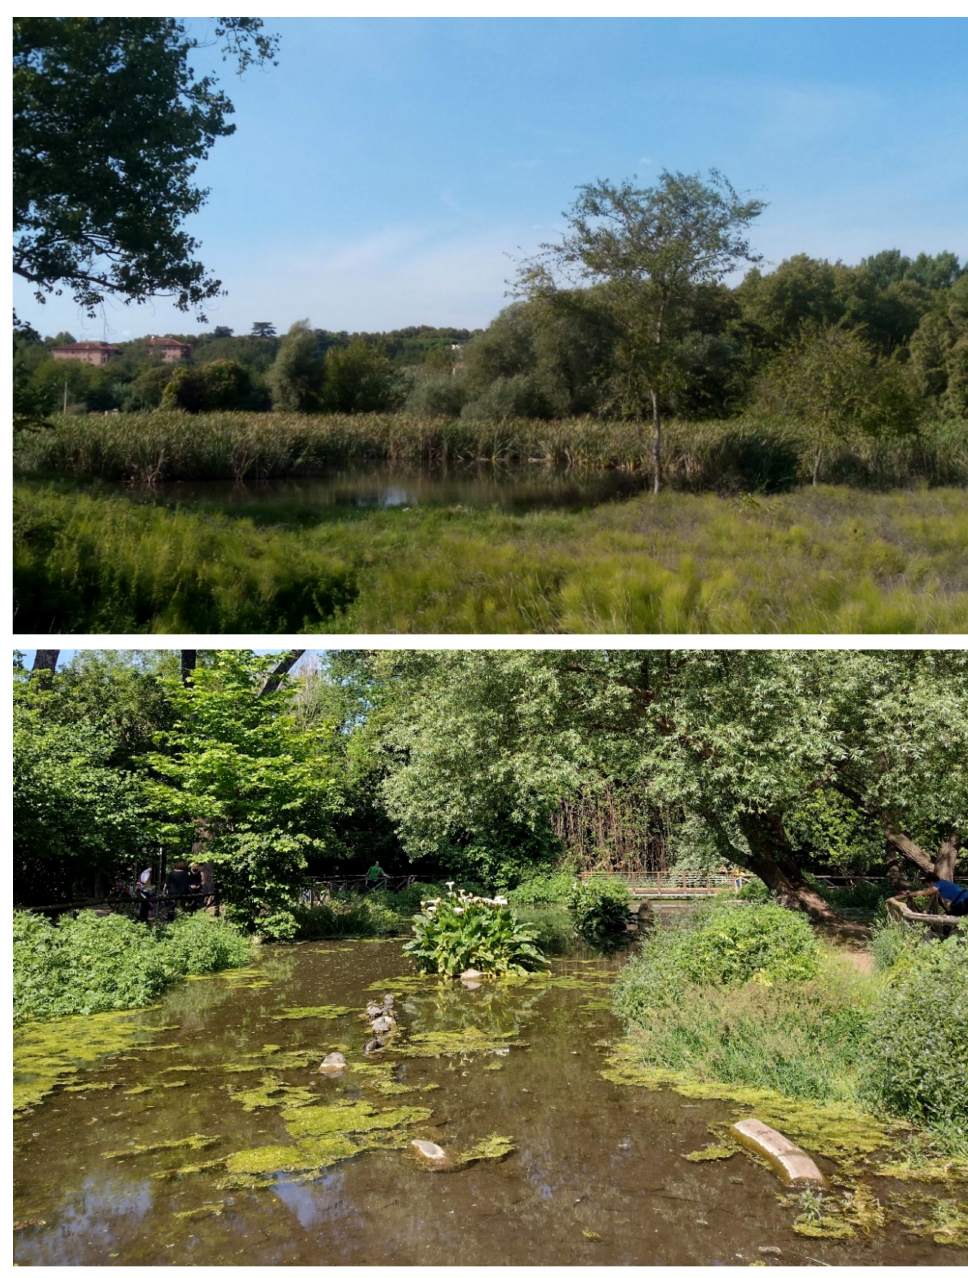
Figure 9. Artificial lakes occurring in Caffarella valley (top photo) and Acquedotti locality (bottom